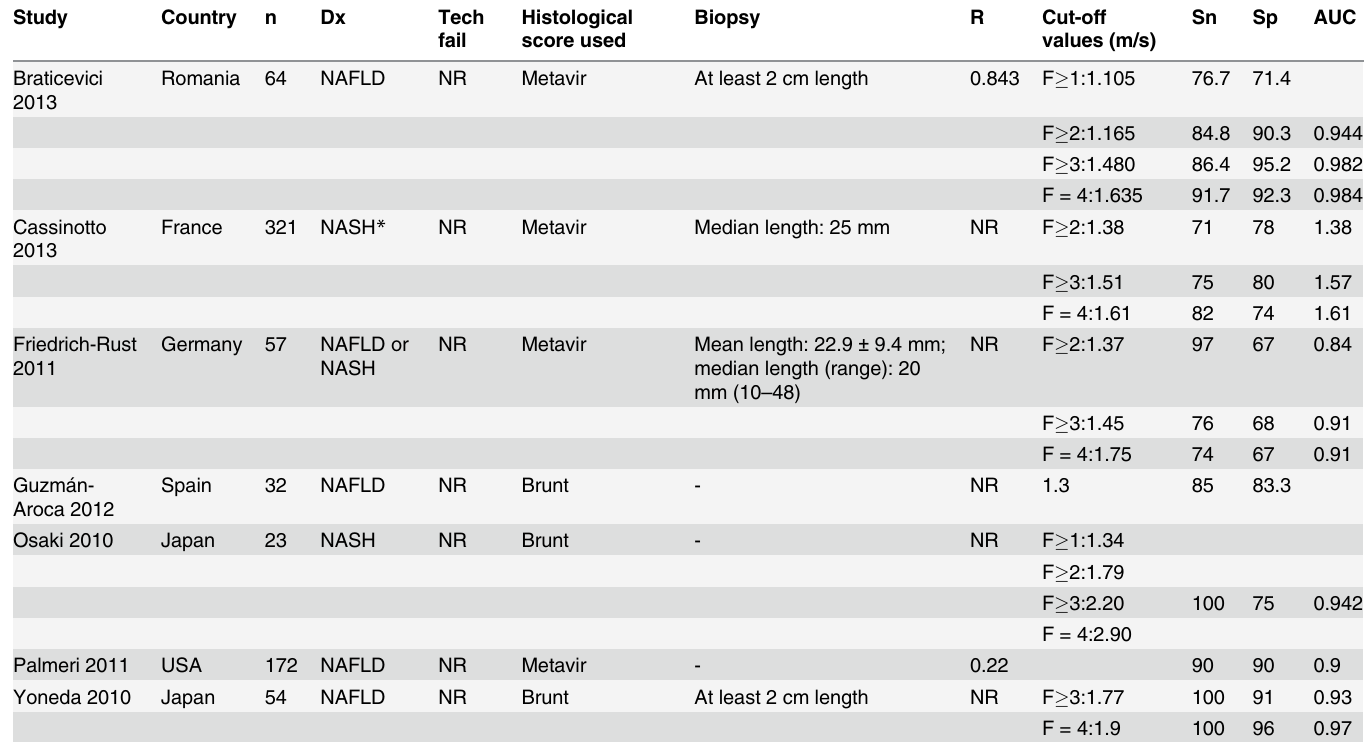
Table 1. Characteristics of Included Studies.